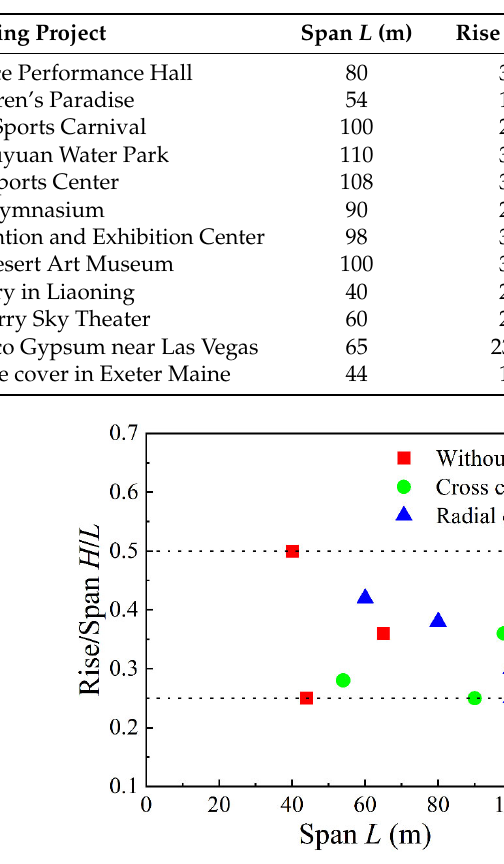
Table 1. Engineering information of spherical inflatable membrane structures.